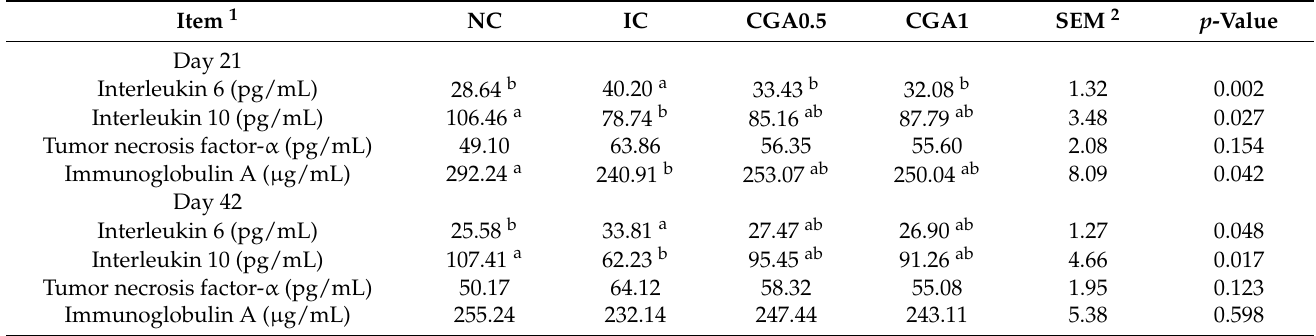
Table 4. Effects of chlorogenic acid (CGA) on immune indices in the serum of broilers ( n =